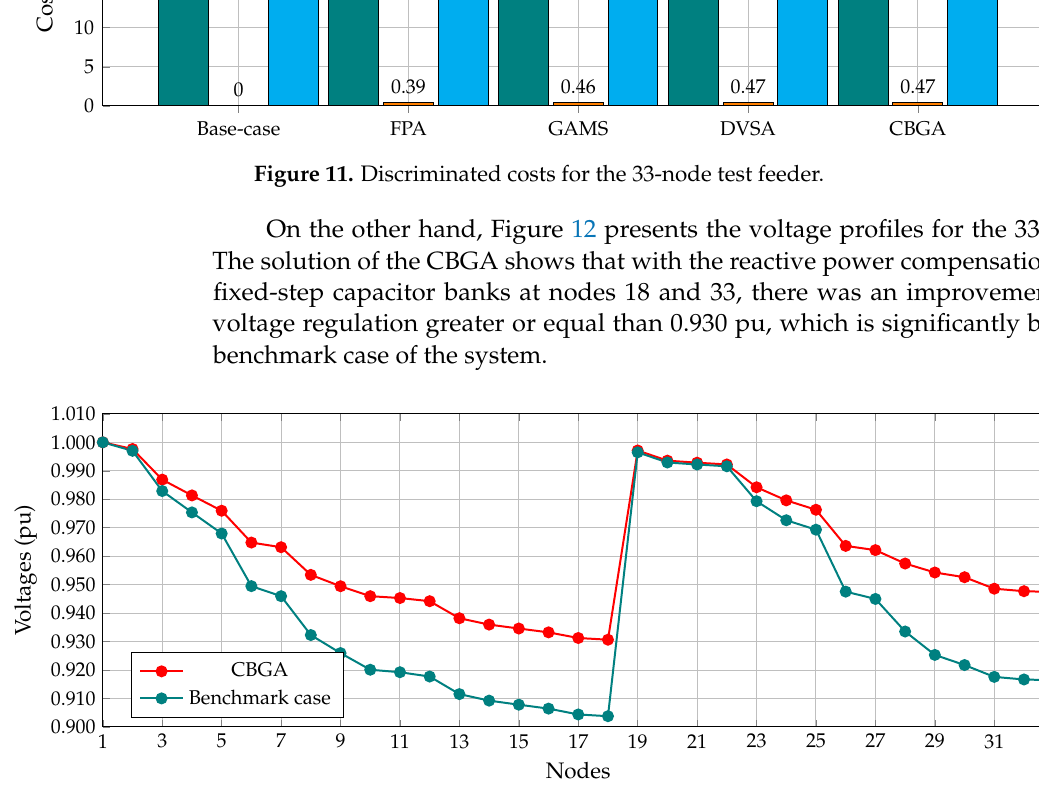
Figure 12. Voltage profiles in the 33-node test